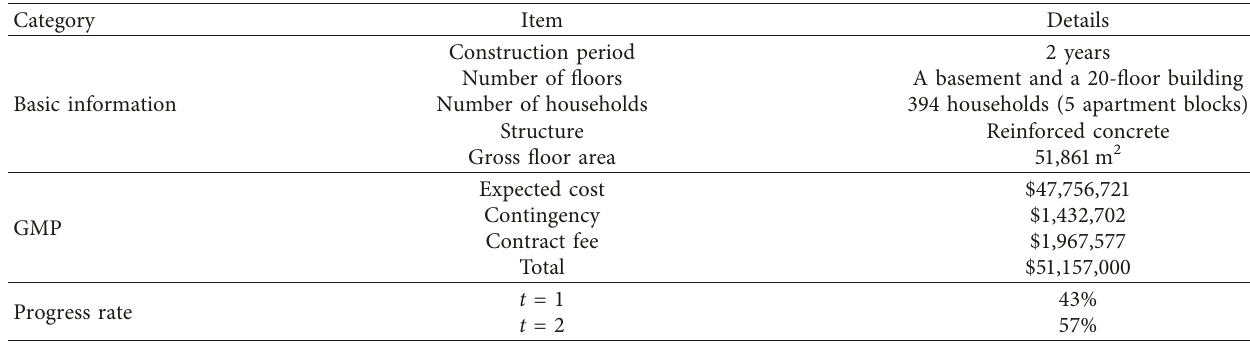
Table 3: Project overview.